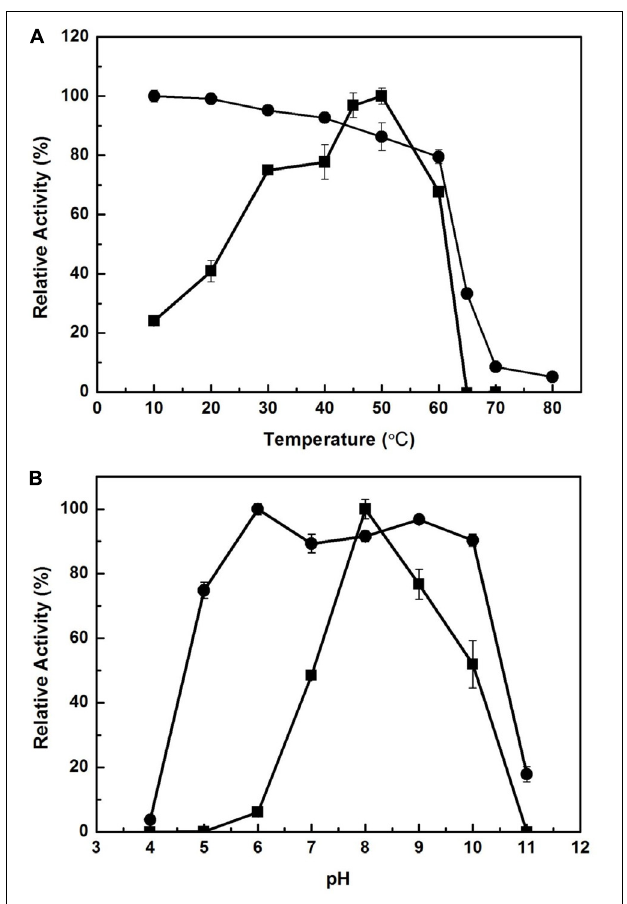
FIGURE 3 | Effect of temperature and pH on the activity of EstCS1. (A) The enzyme activity was measured at each temperature under standard assay conditions ( (cid:4) ). The enzyme was preincubated at the indicated temperatures, and the remaining activity was determined ( • ). (B) The enzyme activity was measured at each pH under standard assay conditions ( (cid:4) ). The enzyme was preincubated at the indicated pH, and the remaining activity was determined ( •